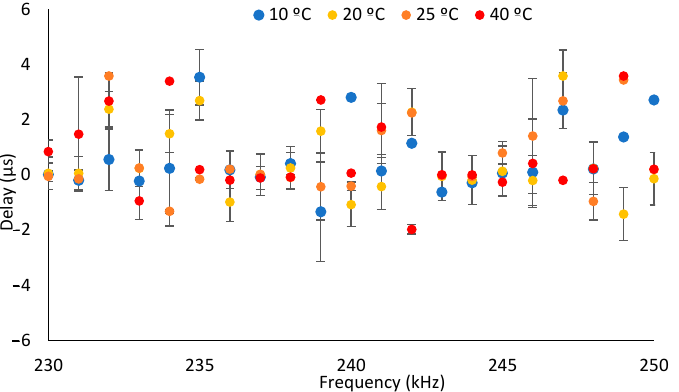
Figure 10. Delay for the selected frequencies according to the pH value. Data include the repetitions performed for the different temperatures.